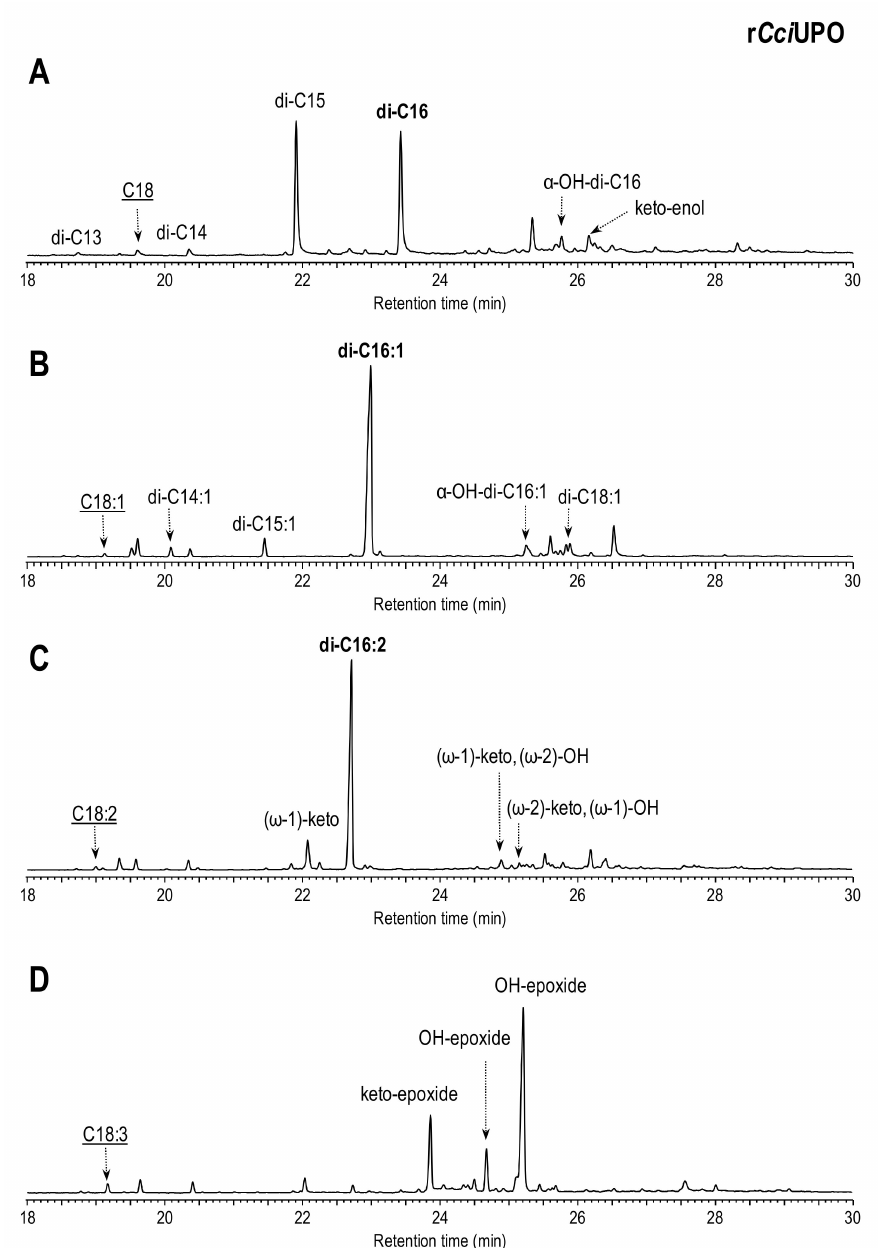
Figure 1. Gas chromatography-mass spectrometry (GC-MS) analysis of r Cci UPO reactions with 0.1 mM stearic ( A ), oleic ( B ), linoleic ( C ) and linolenic ( D ) acids (underlined), showing the dicar- boxylic acids (in bold), together with the hydroxy, keto, enol and epoxide derivatives. Reaction conditions: A (1.4 µ M enzyme, 20 mM H 2 O 2 , 25 h) and B, C, D (0.2 µ M enzyme, 2.5 mM H 2 O 2 , 0.5